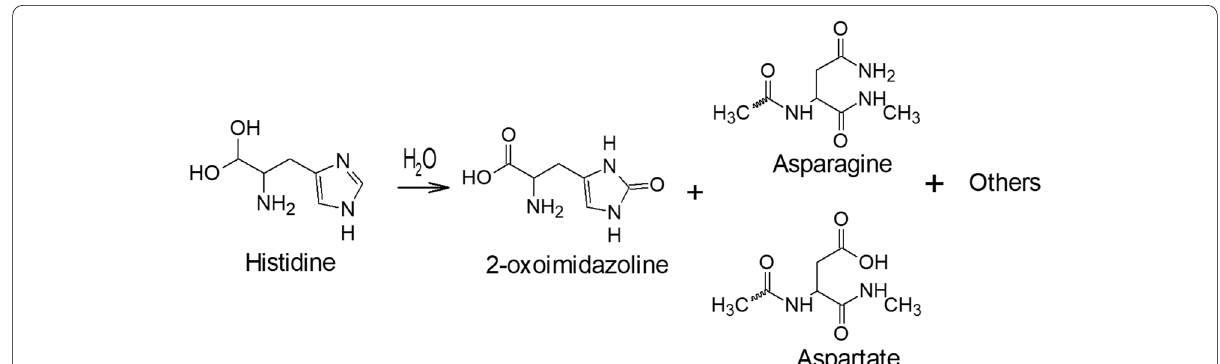
Fig. 3 Oxidation reaction of histidine through an oxometallocyclic intermediate to form various degradation products, such as 2-oxomidazoline, asparagine, and aspartate